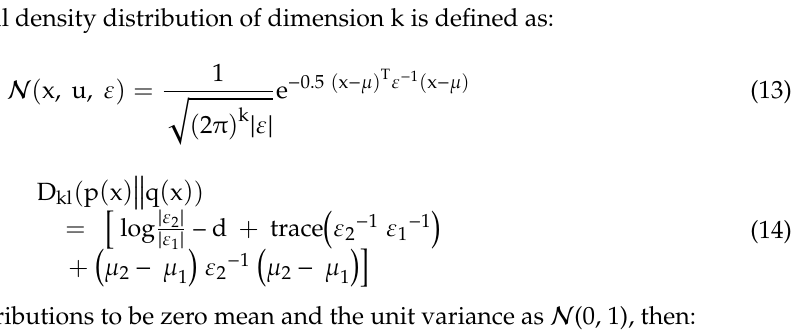
Figure 3. High-level view of the architecture. There are ten models/generators; each specializes